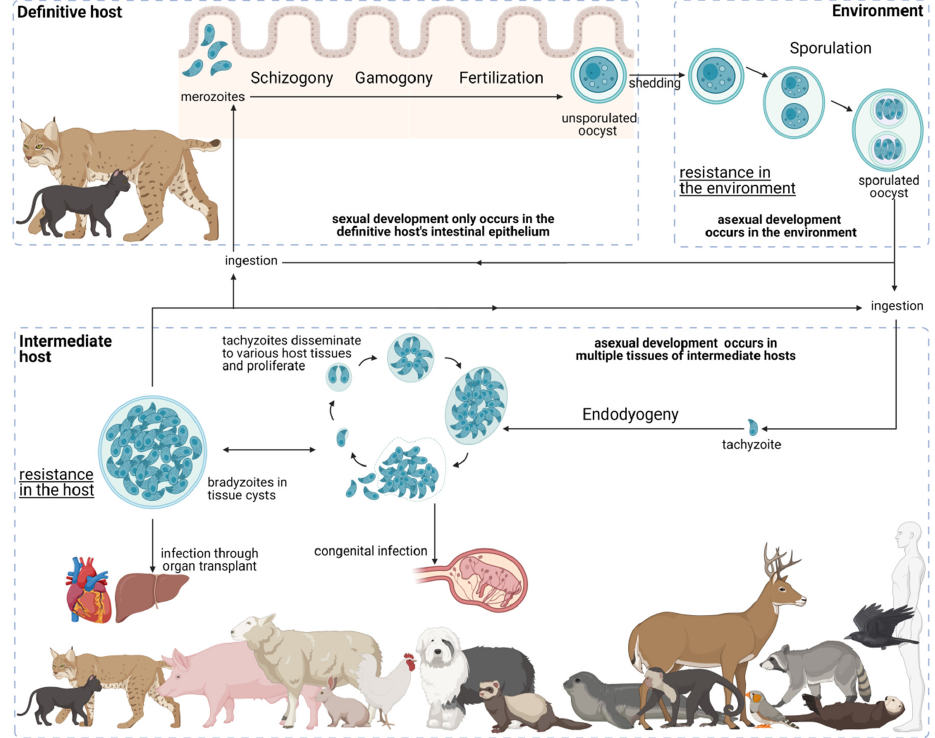
Figure 3. Life cycle of Toxoplasma gondii . The T. gondii life cycle includes three main phases of development: in the definitive host, in the environment, and in the intermediate host (highlighted in grey interrupted lines). The various parasite stages and biological events are indicated relative to the development phase as well as to how the different entities interact. Created with BioRender.com (accessed on 5th December 2021).